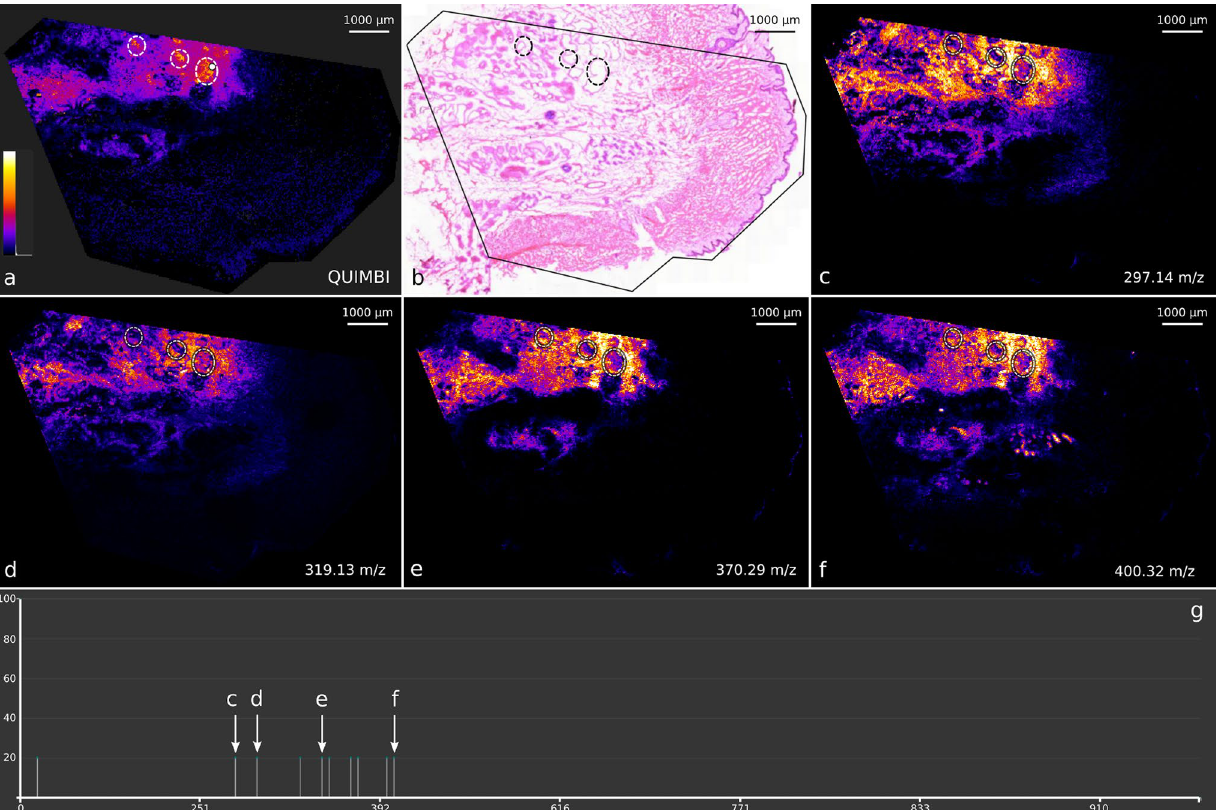
Figure 7. QUIMBI visualization ( a ) of human PXE skin showing a distinct distribution which is based on weak signals. ( b ) shows the corresponding histology and ( c )–( f ) selected single mass channel images. In this example visualization, the selected reference pixel in ( a ) comprises ten mass channels with a non-zero signal which are scaled to the same signal intensity due to the 8-bit scaling ( g ). The marked regions (dashed white lines) show a molecular distribution which is visible in the QUIMBI visualization ( a ) but not in the single mass channel images ( c ) to ( f ). All single mass channel images can be found in Supplementary G. The image intensity scale in ( a ) shows the similarity of pixels from black (dissimilar) to white